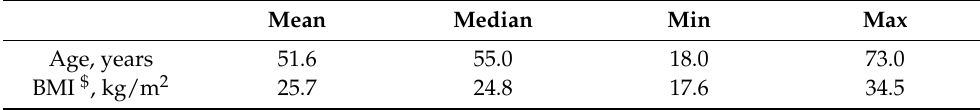
Table 1. Demographics of the study cohort (N = 28,